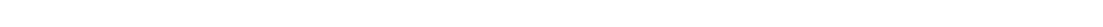
Table 1. Logic Model for the After-School Garden Program in Athens-Clarke County, Georgia (ACC) Situation: With rising food prices and economic recessions, food-insecure ACC residents, especially children, will face continued challenges around having consistent and dependable access to enough food for active and healthy living. The need is becoming increasingly urgent to identify sustainable, empowering strategies to increase access to healthy foods for people at all income